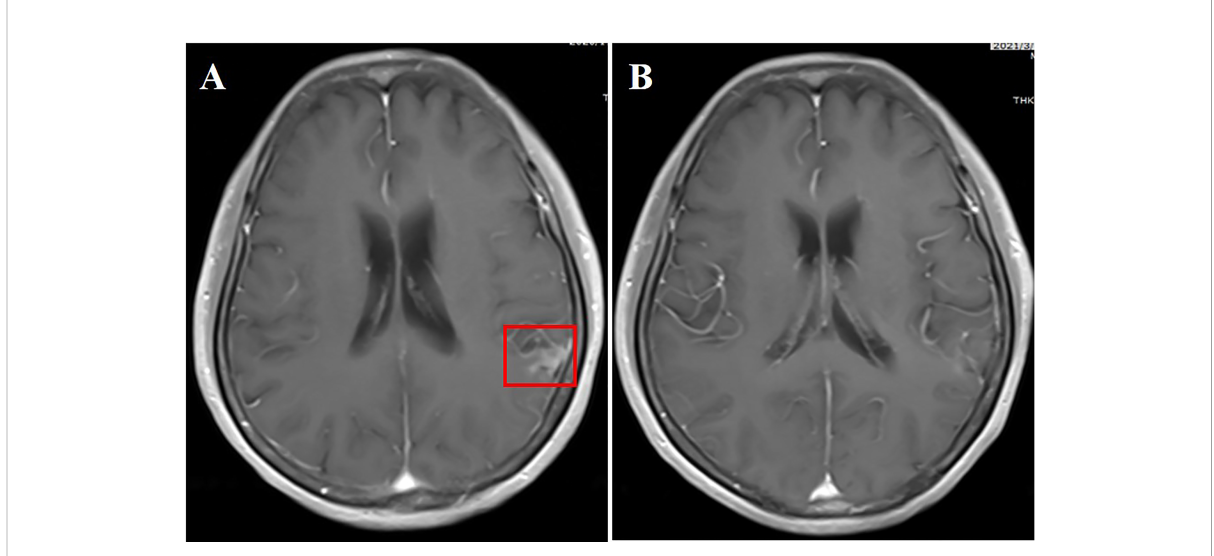
FIGURE 5 (A) Cranial enhanced MRI showing patchy high signals in the left temporal lobe (red box); (B) high signals of leptomeninges disappeared 2 months after aumolertinib plus bevacizumab